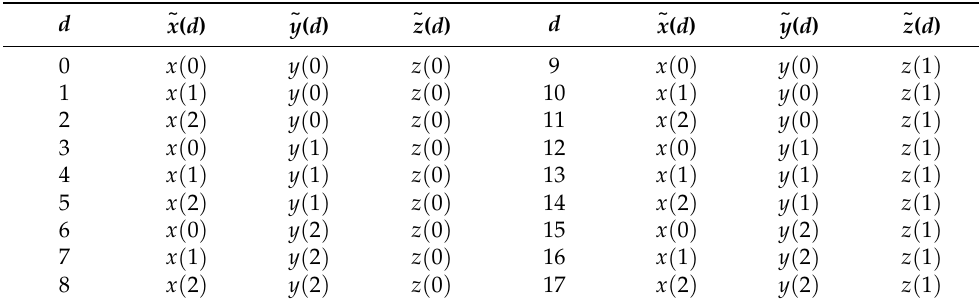
Table 1. Order of arrangement of the x , y , and z coordinates of the child subimage centers in a modified Morton order curve with a (3 × 3 × 2)